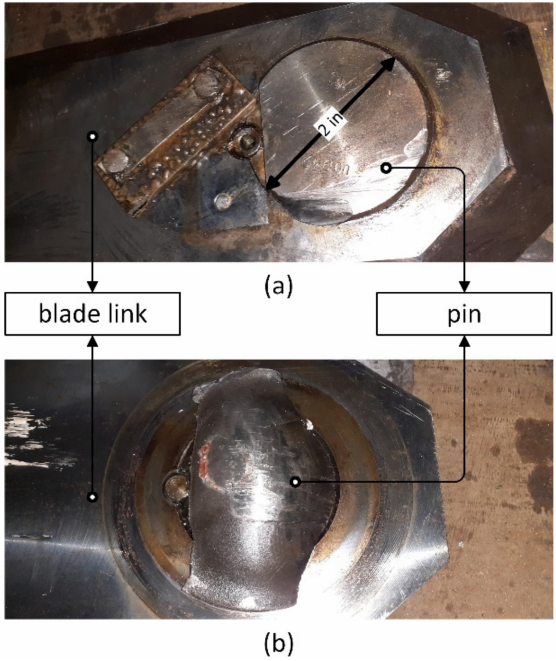
Figure 2. Blade link and sheared pin: front view ( a ) and back view ( b